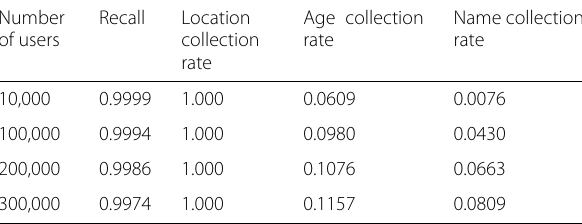
Table 2 Performance of the incremental approach Number of users